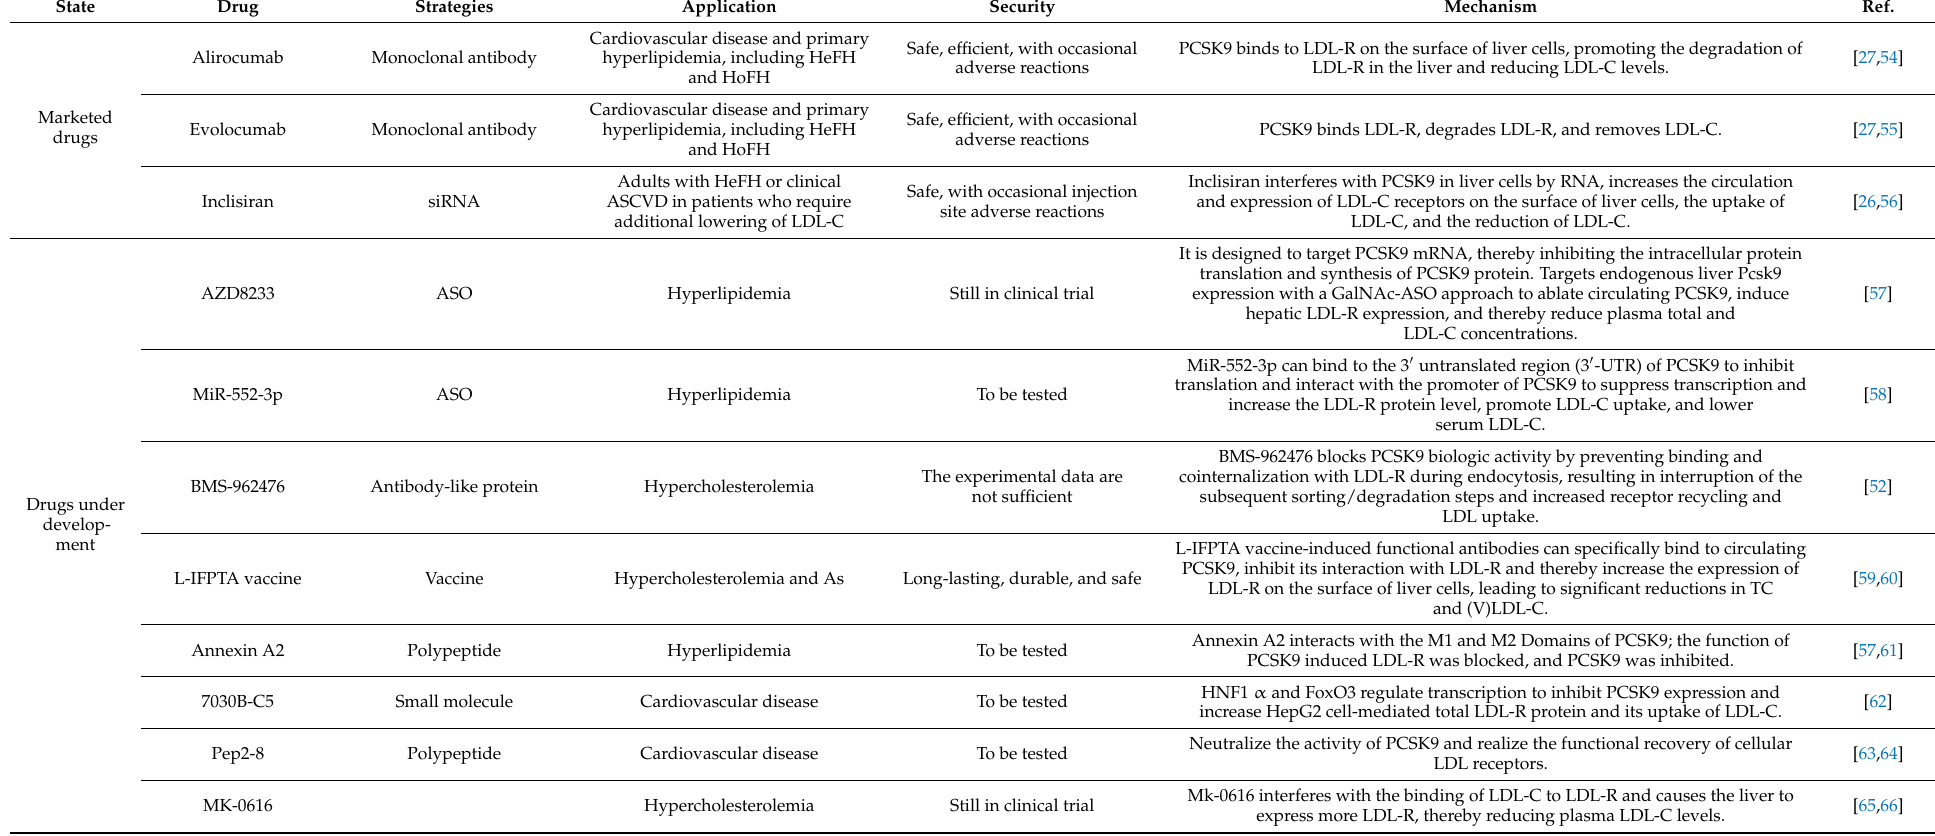
Table 1. Application of PCSK9 inhibitors with different strategies in